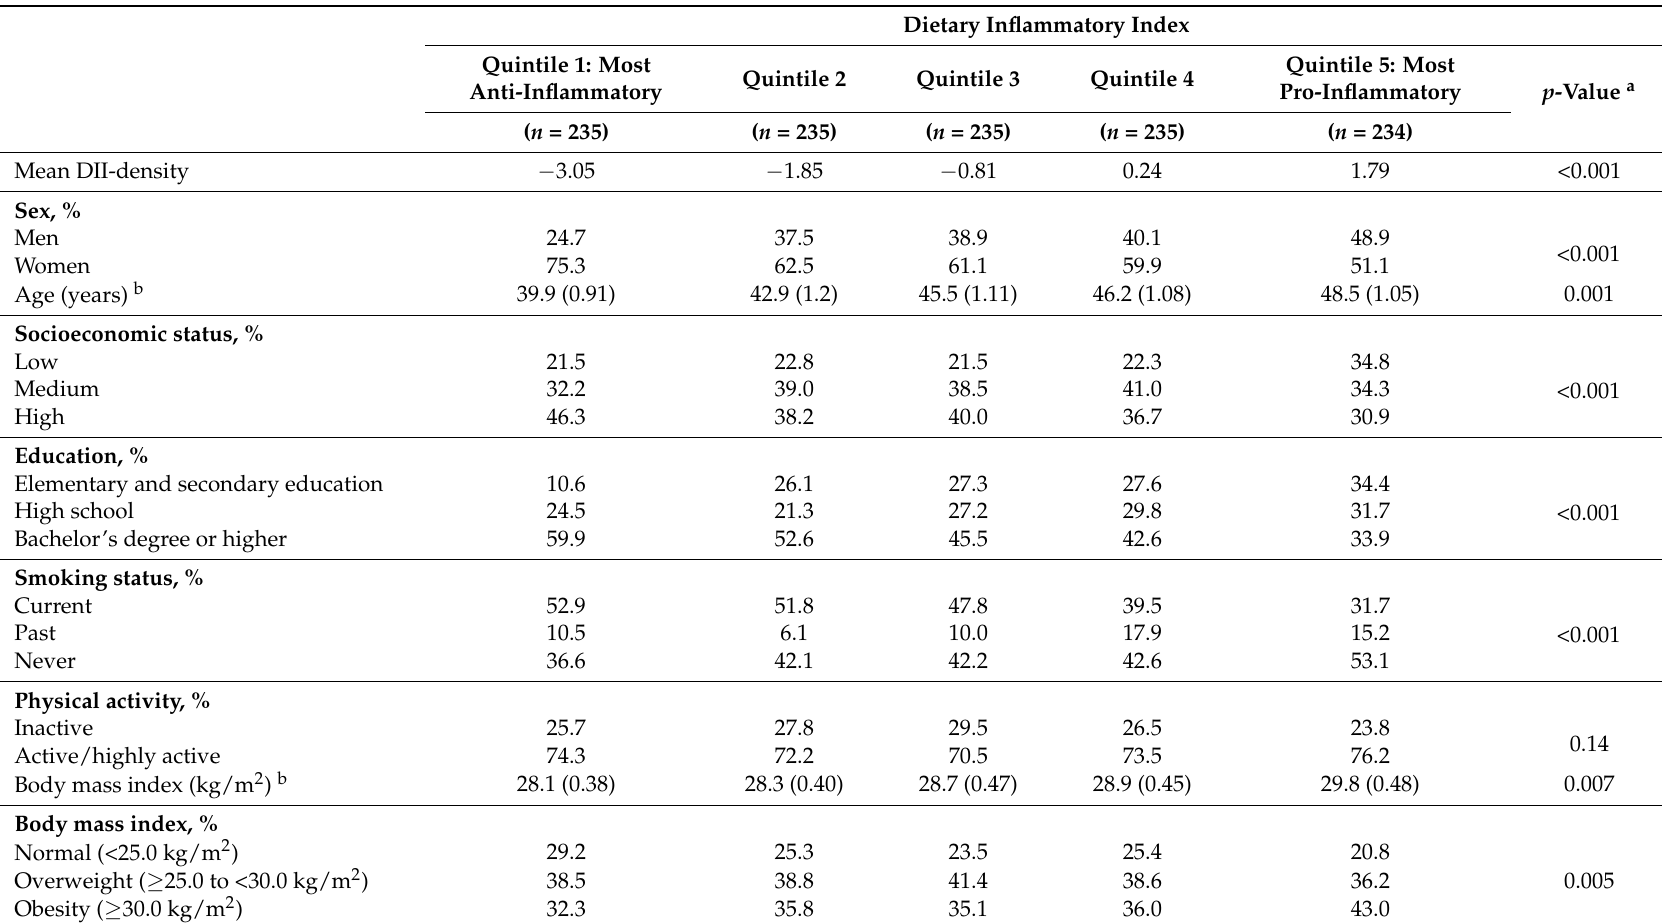
Table 2. Characteristics of participants according to quintiles of the dietary inflammatory index: The Diabetes Mellitus Survey of Mexico City,